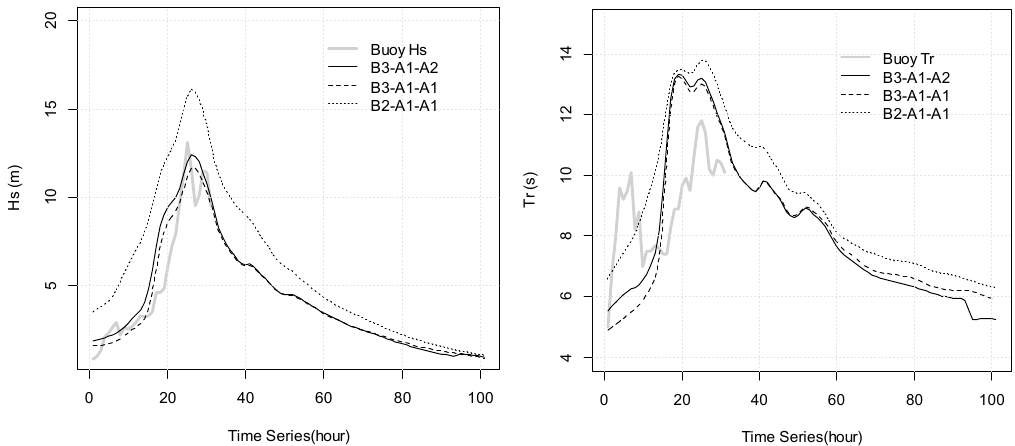
Figure A8. Comparison of typhoon waves induced by Typhoon Meranti (14-2016) at buoy Taitung Open Ocean: the standard H10 is indexed as B2-A1-A1, the model with varying parameter b without an asymmetric typhoon structure is indexed as B3-A1-A1, and MH10 is indexed as B3-A1-A2.